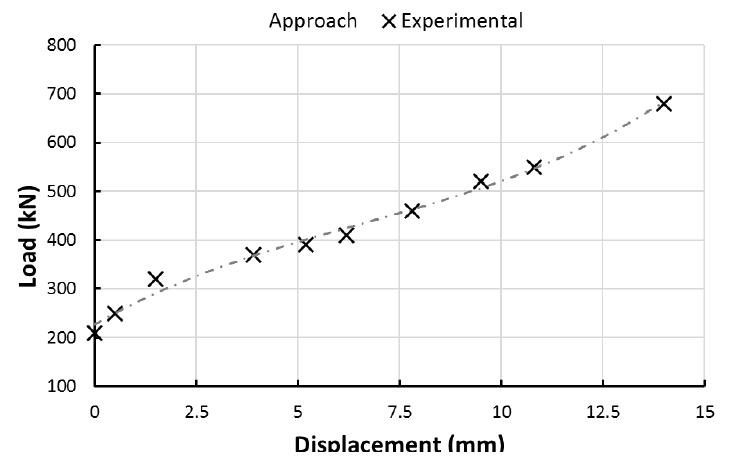
Figure 1. Experimental and numerical approximation of the compression tests.